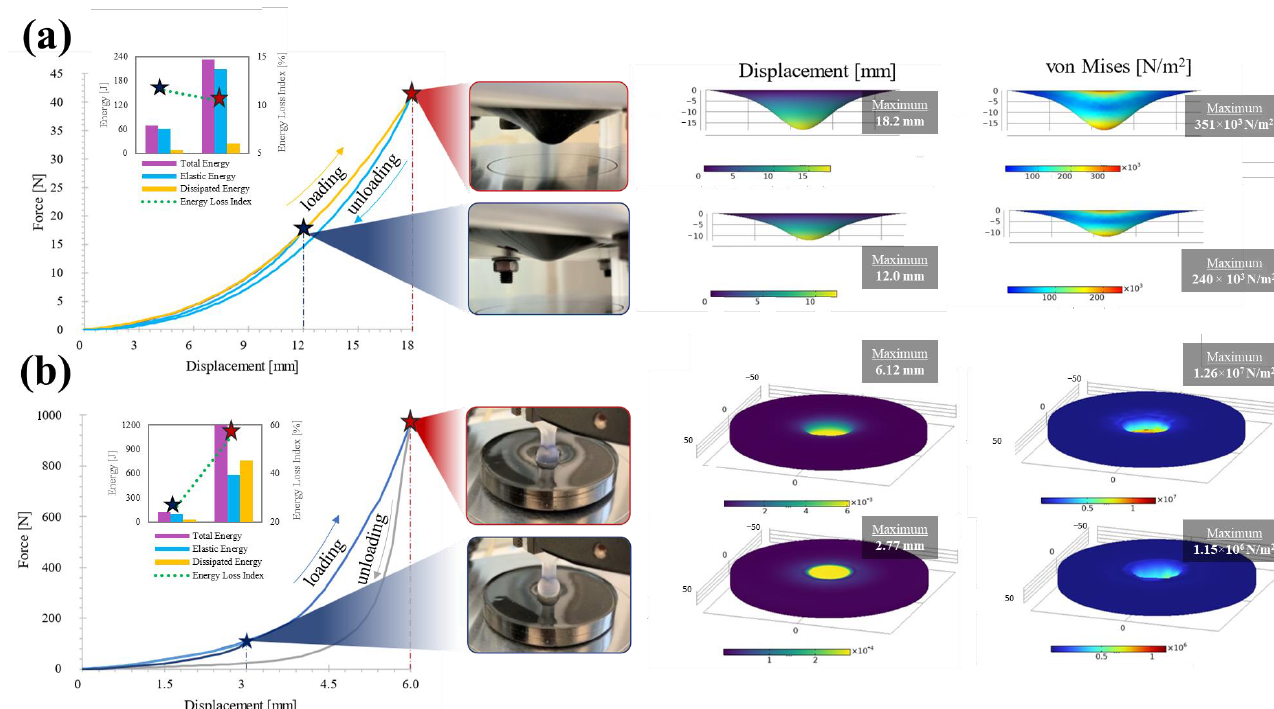
Figure 7. Non-conventional mechanical tests to demonstrate nonlinear behavior and energy losses in flexible materials under various nonlinear mechanical deformation conditions; ( a ) Spring-driven deformation, ( b ) Damper-driven